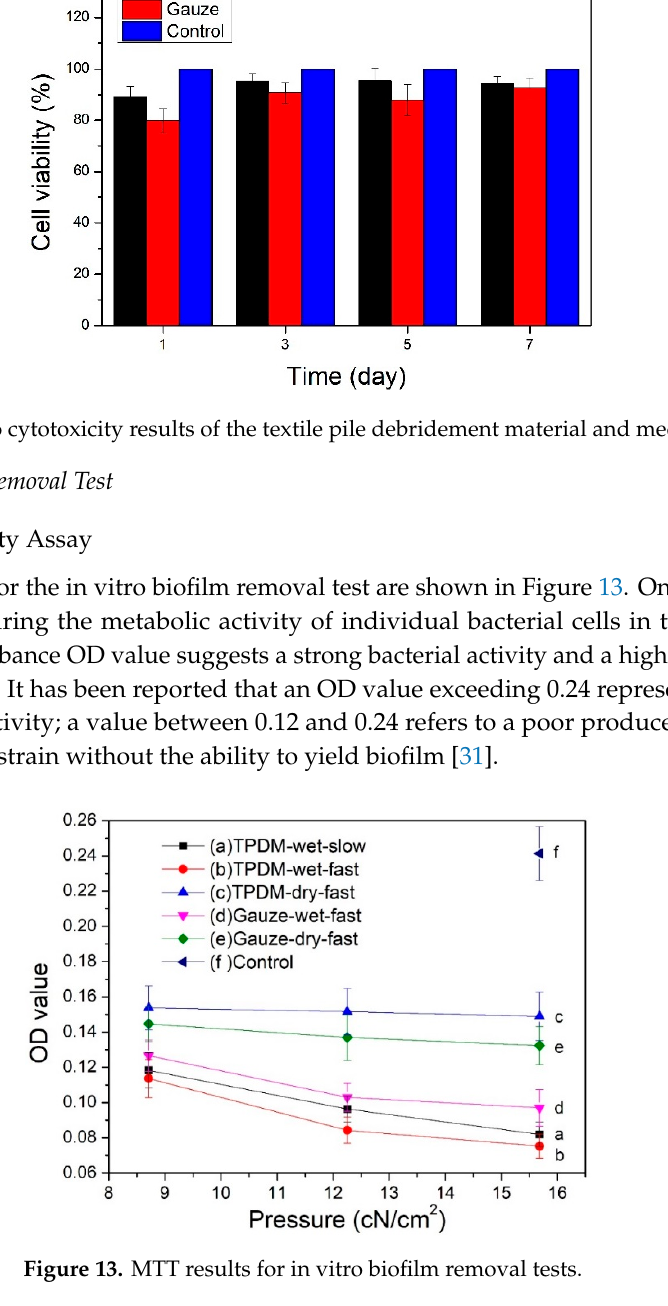
Figure 11. SEM images of ( a ) the textile pile debridement material and ( b ) medical gauze at 30 min in the blood coagulation test.